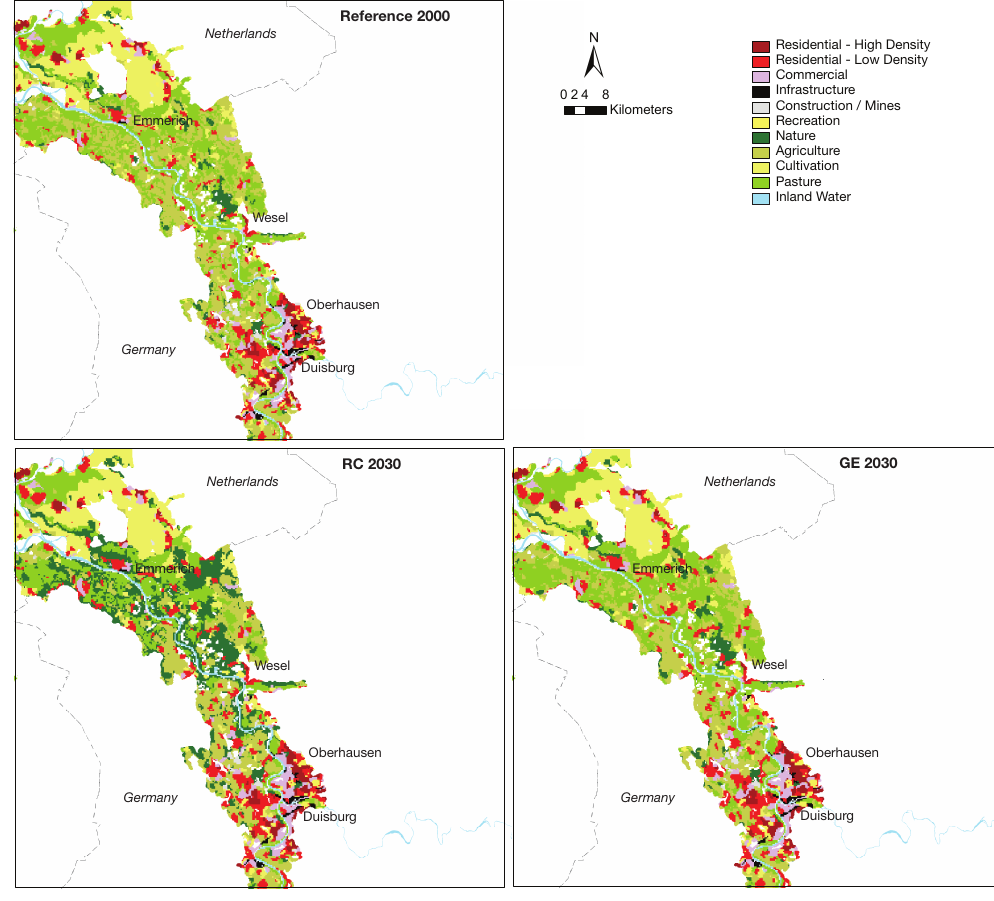
Fig. 4. Land use maps for the reference year 2000, and for 2030 under the RC and GE socio-economic scenarios. The image is zoomed on the Lower Rhine near the border between Germany and the Netherlands, and shows only land use types in flood-prone areas.